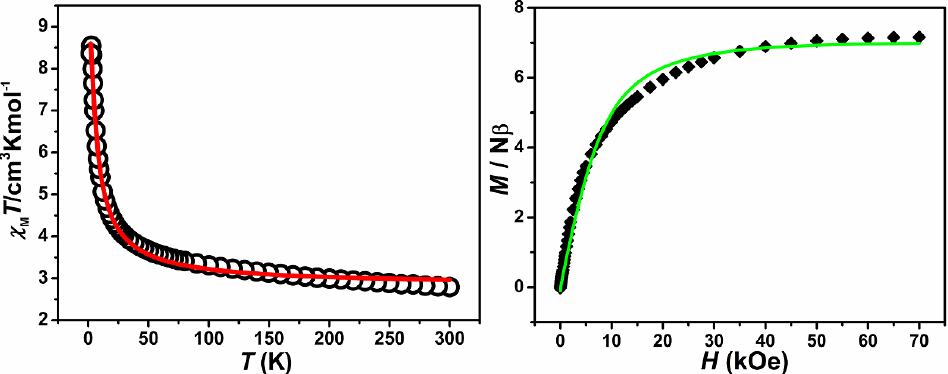
Figure 5. ( left ) χ M T versus T chart of [Cu 2 (hfac) 4 (NIT-3Py-5-4Py)] n ( 2 ) (the crimson line denotes the fitting results). ( right ) M versus H chart for 1 at 2 K (the green curve denotes the calculated behavior for the total of the Brillouin functions with seven free S = 1/2 spins).